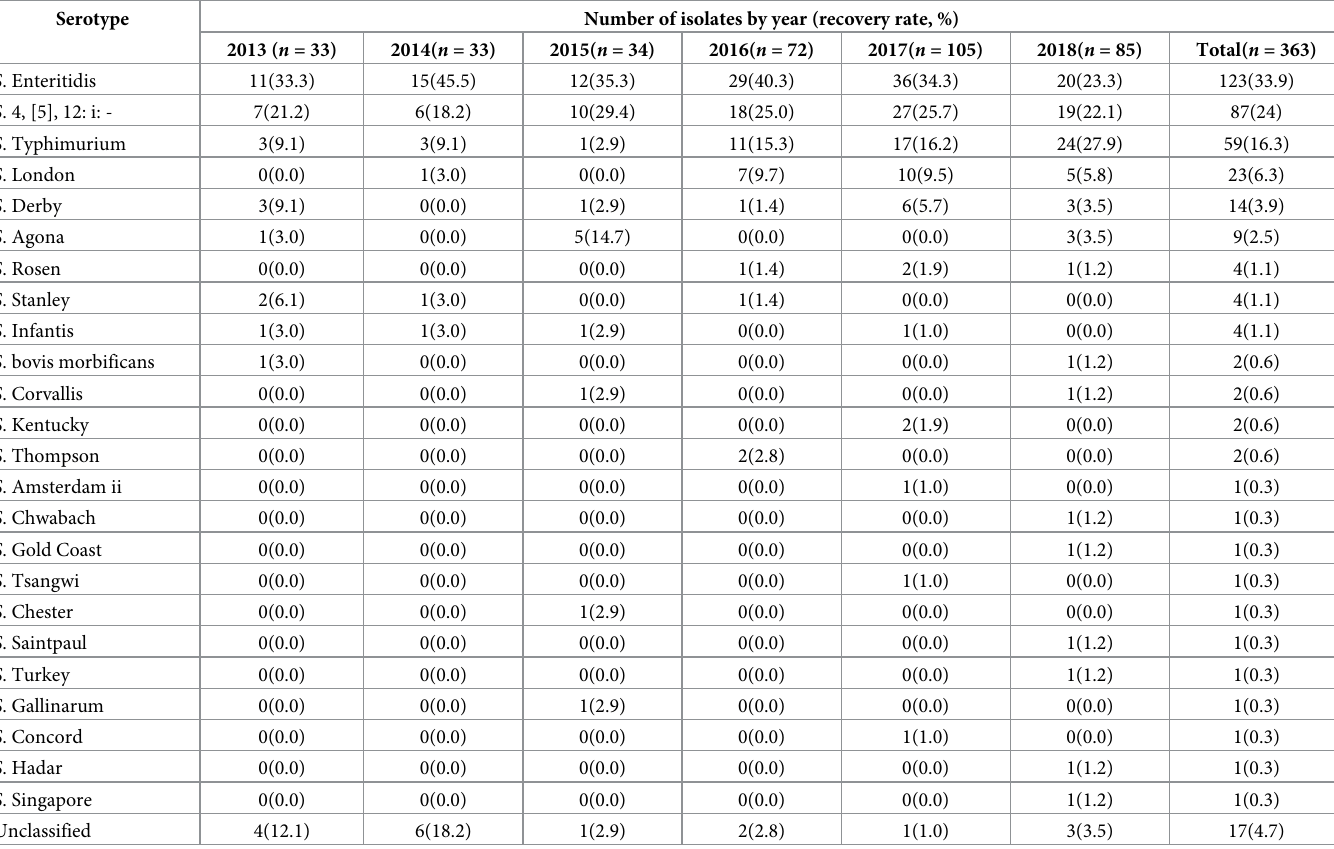
Table 1. The serotype distribution of human Salmonella isolates in Guizhou province, China, from 2013 to 2018.